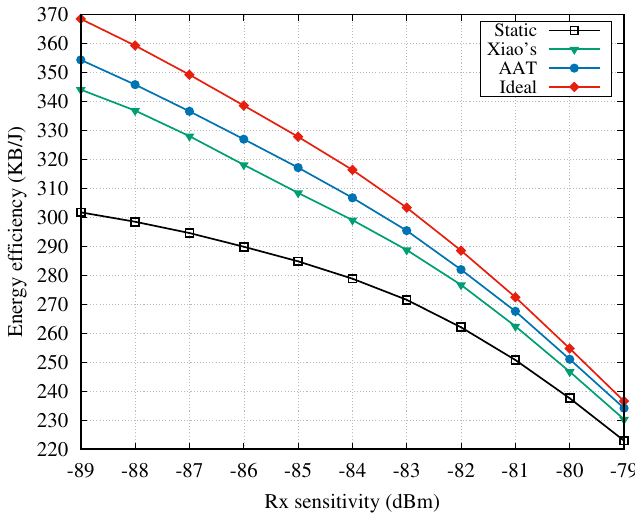
Figure 8. Energy efficiency vs. Rx